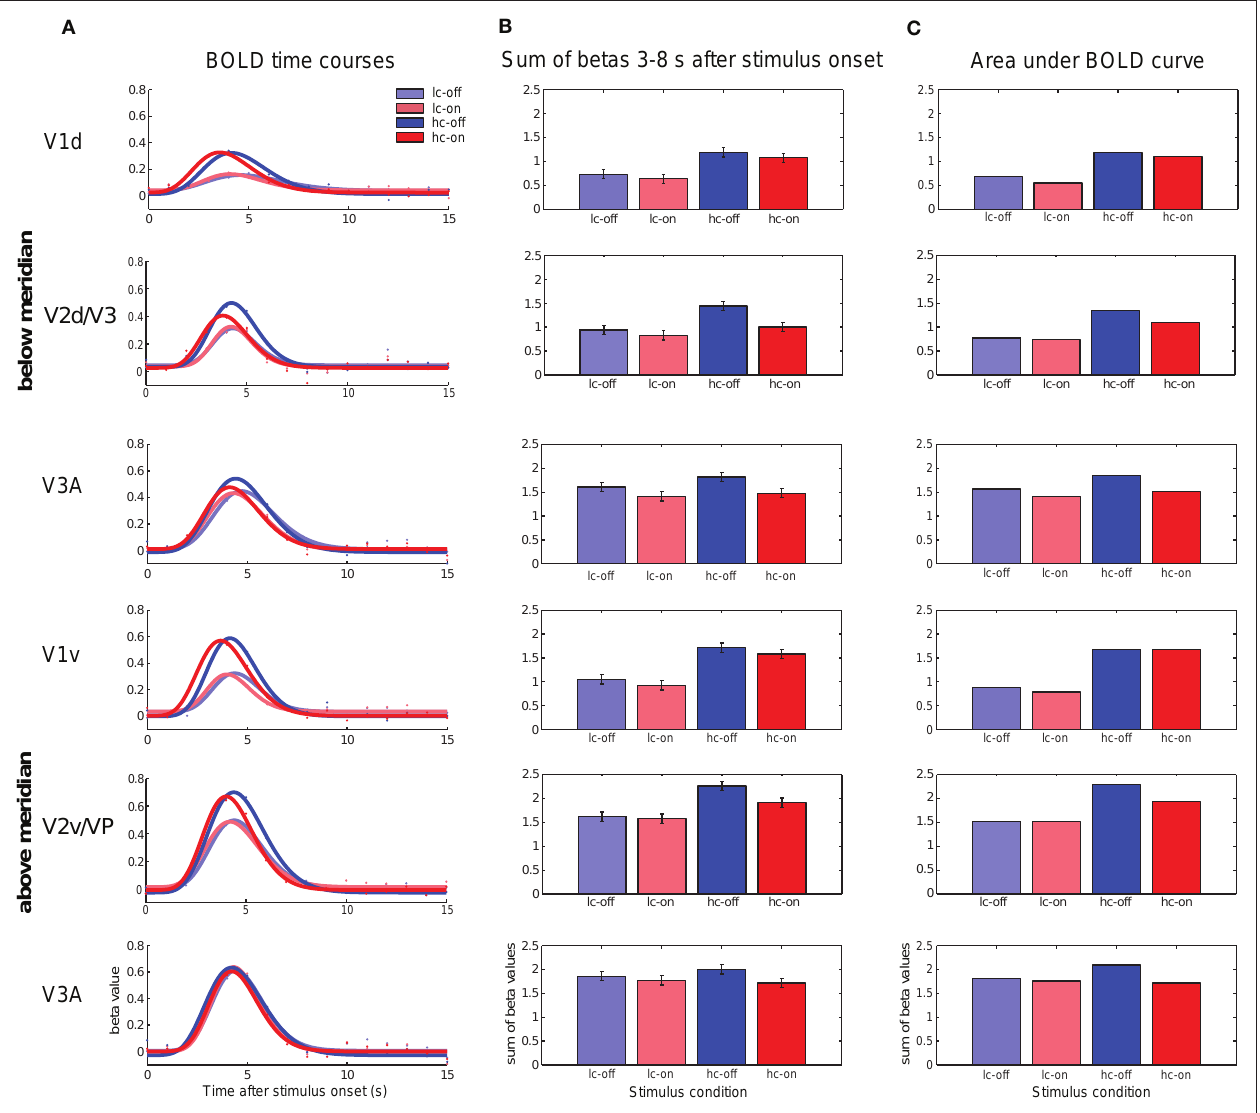
FIguRe 4 | (A) BOLD time courses (as reconstructed by a fixed-effects deconvolution GLM) in response to the four motion conditions and fitted gamma- functions. (B) Sum of beta values from the deconvolution GLM in a time window 3–8 s after stimulus onset. (C) Area under curve as an index of BOLD response